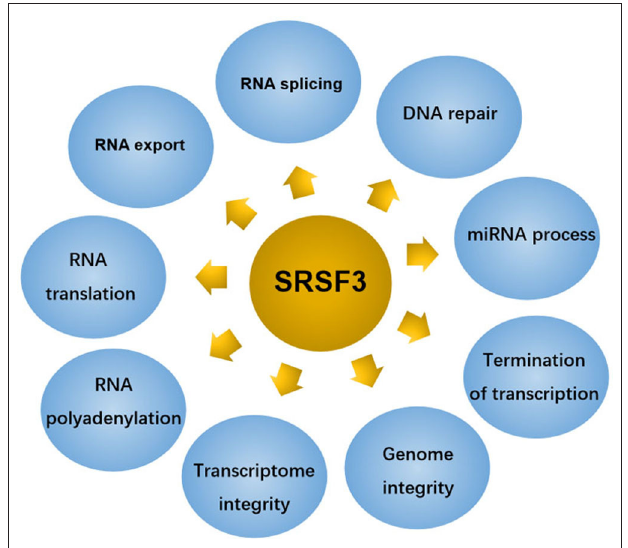
FIGURE 2 | SRSF3 regulates several cellular functions in eukaryote